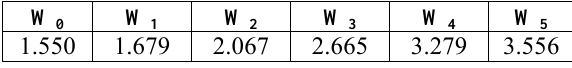
Table1: Width of Chebyshev transformer sections(mm).